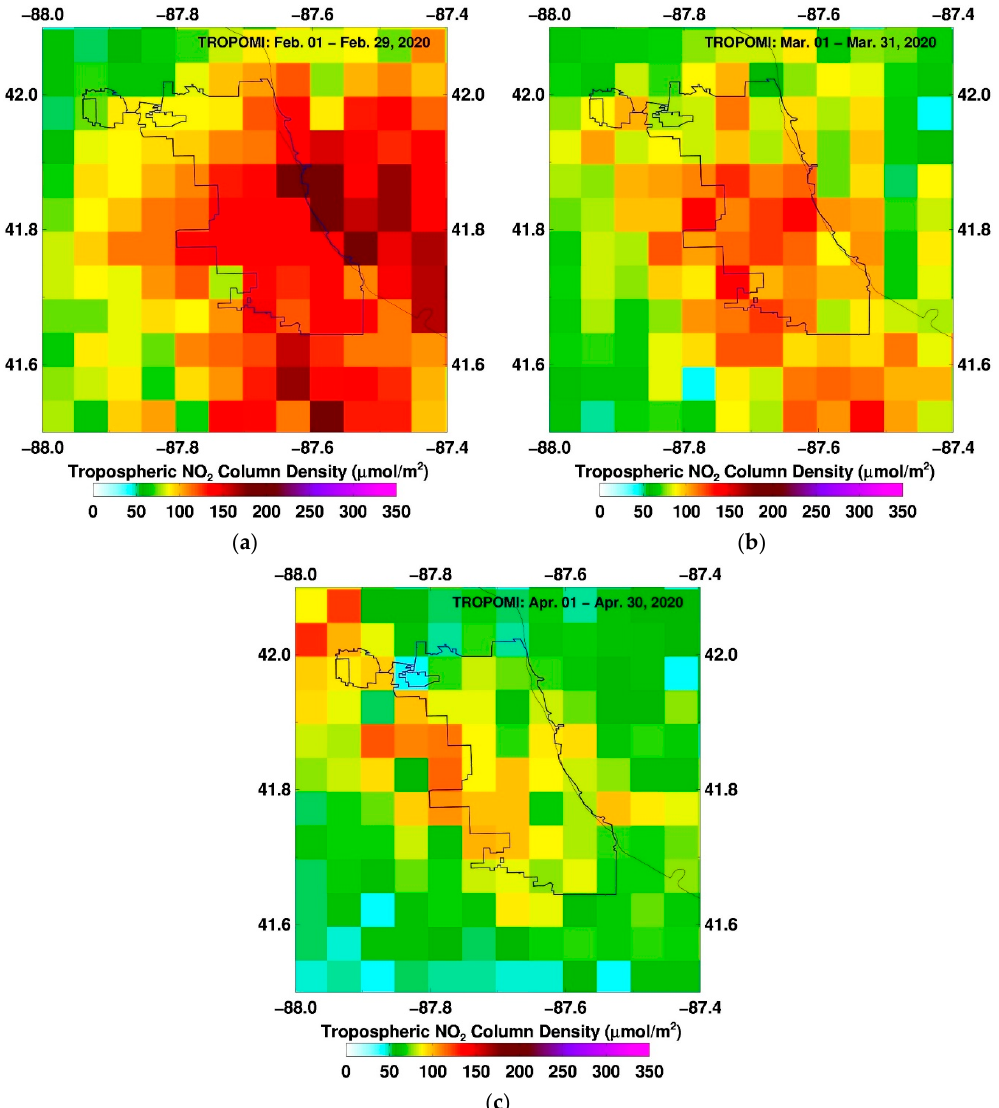
Figure 13. Distribution of NO 2 concentration in Chicago in February ( a ), March ( b ) and April ( c ).